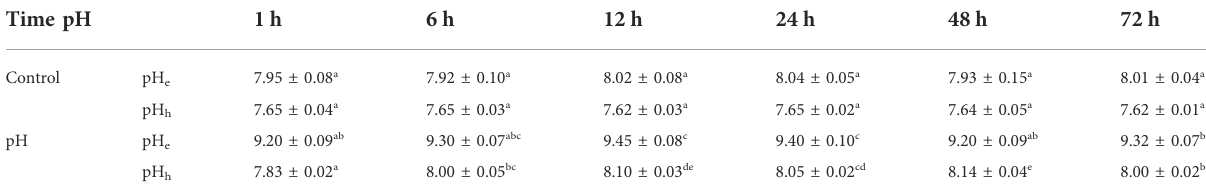
TABLE 1 The hemolymph pH of E. carinicauda under pH stress.